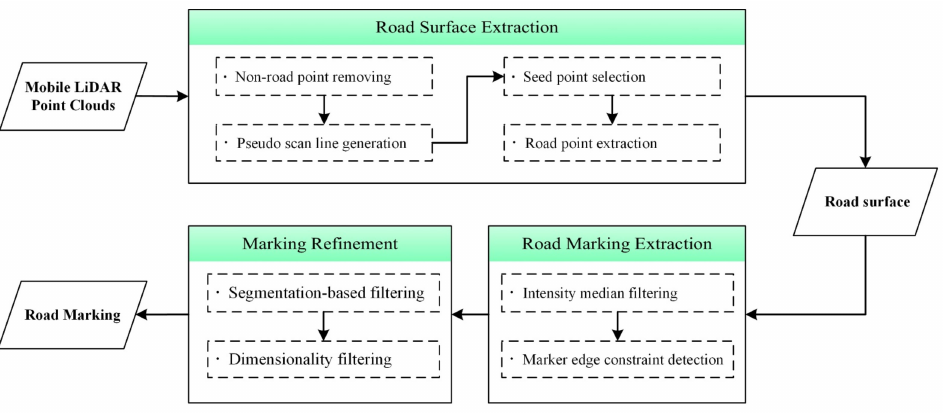
Figure 1. An overview of the proposed detection